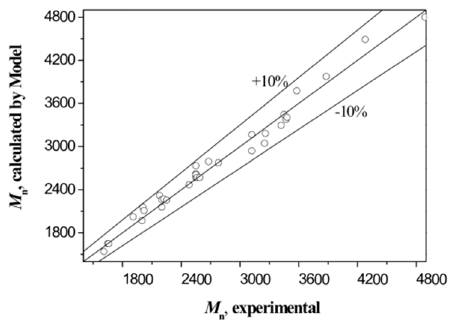
Figure 8. Comparison between experimental and modeling M n .